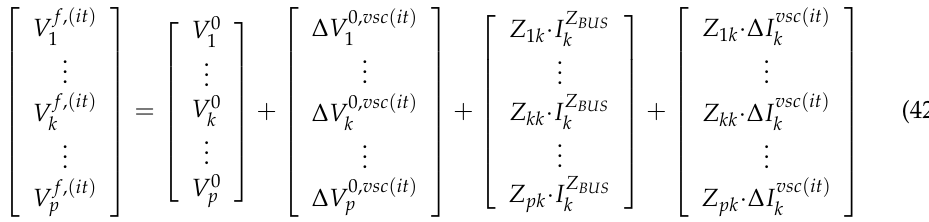
Figure 3. Short-circuit current (relative to the non-VSC value) considering a VSC connected at the faulted bus, for different SCR values and for two different operating modes.